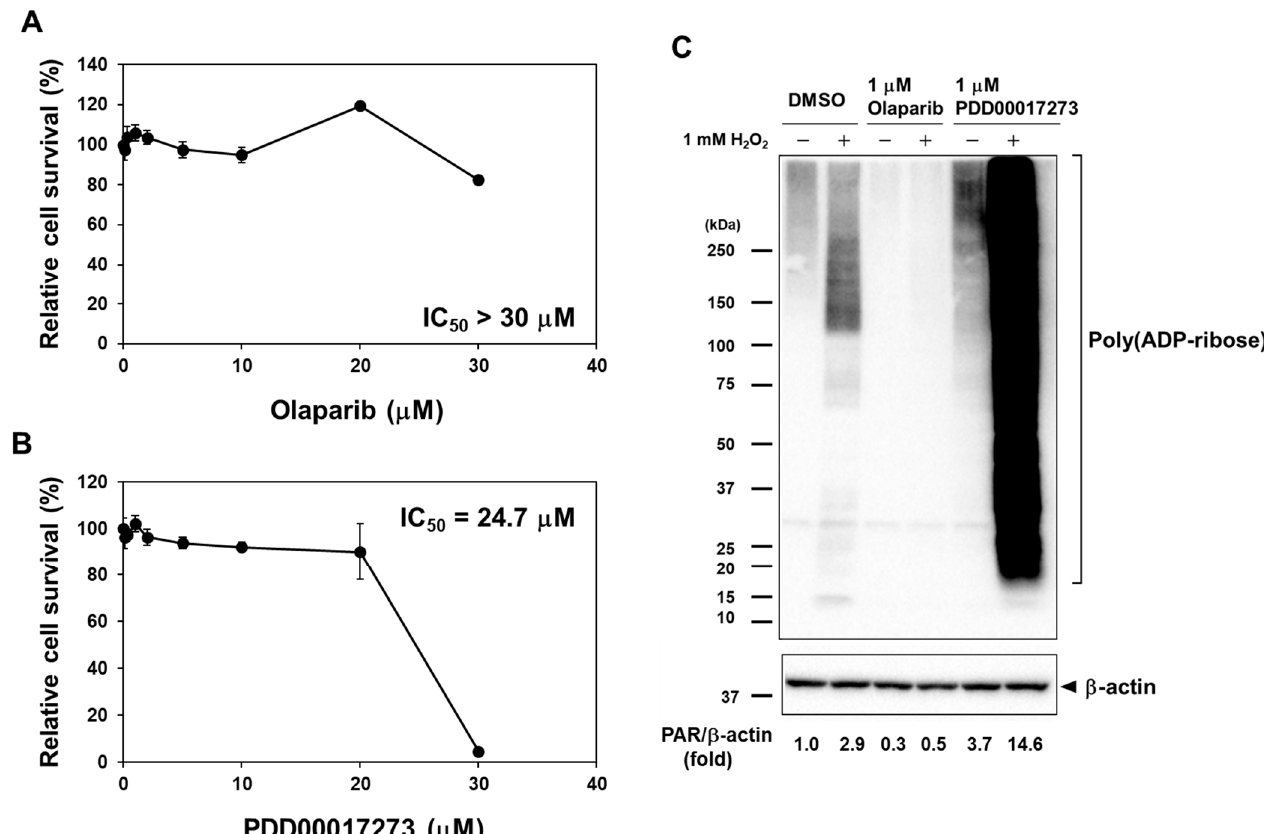
Figure 1. Effects of olaparib and PDD00017273 on cell cytotoxicity and PARylation activity in MC3T3-E1 cells. ( A , B ) Cell viability in olaparib- and PDD00017273-treated MC3T3-E1 cells. MC3T3-E1 cells were cultured in the condition of serum starvation for 24 h, and then treated with olaparib or PDD00017273 at concentrations of 0–30 µM in differentiation medium for 3 days. Cell viability was measured by CCK assay. ( C ) Intracellular PAR levels in MC3T3-E1 cells after treatment with olaparib and PDD00017273. MC3T3-E1 cells were treated with DMSO (solvent), 1 µM olaparib, or 1 µM PDD00017273 for 24 h, and then incubated in the absence or presence of 1 mM H 2 O 2 for 10 min. Whole-cell extracts were analyzed by Western blotting using an anti-PAR antibody.